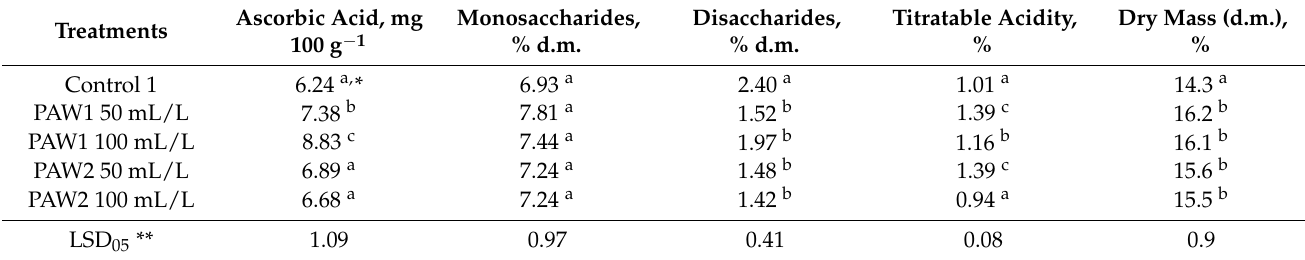
Table 4. Contents of some bioactive compounds in apple fruits.